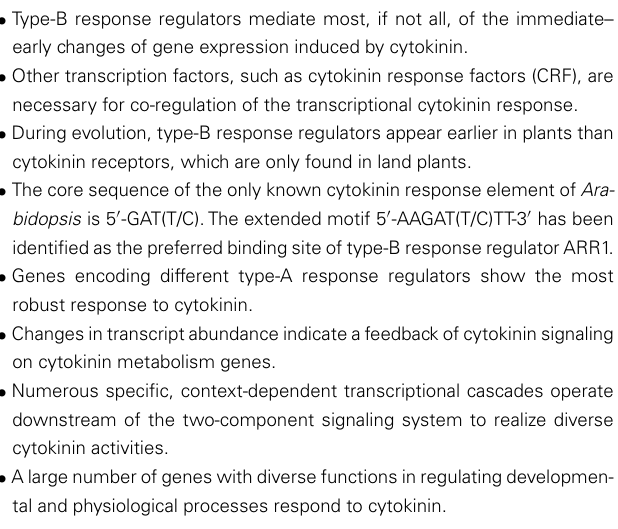
Table 1 | Key facts about cytokinin-regulated gene